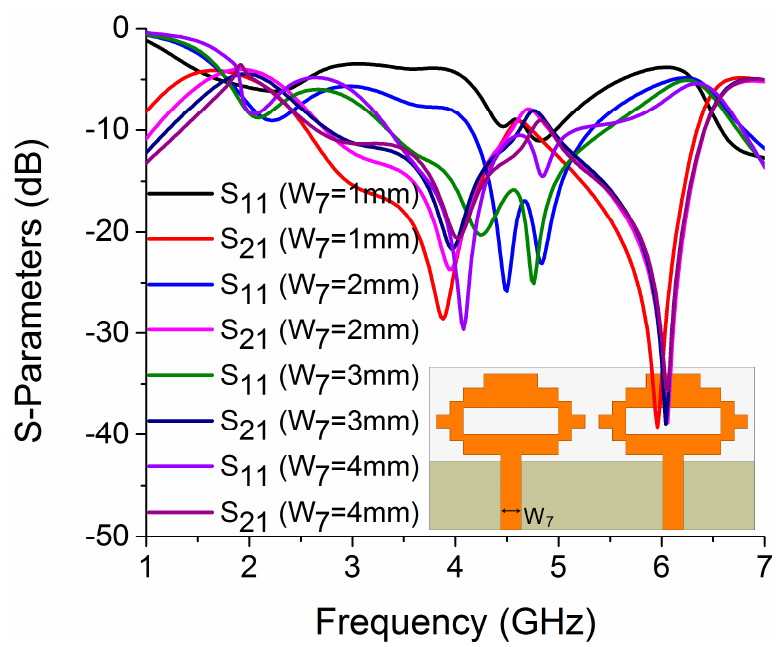
Figure 20. Influence of W 7 on S-parameters.